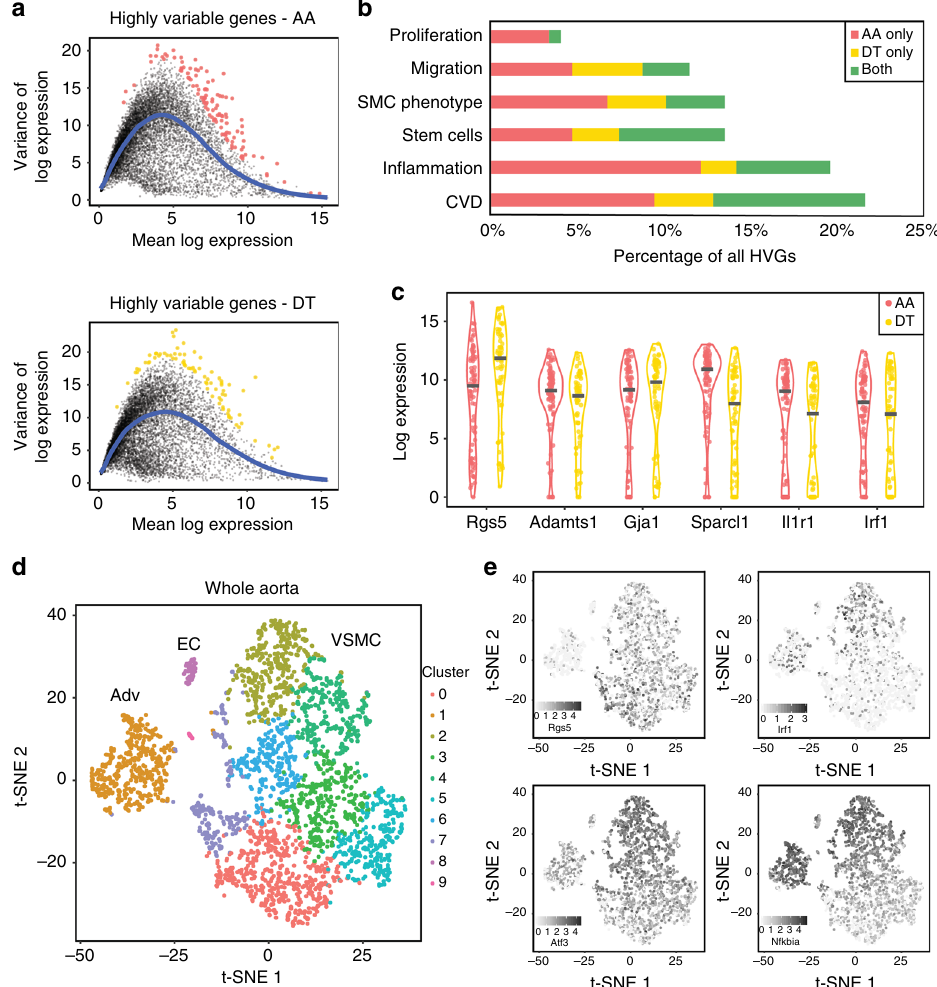
Fig. 4 VSMCs show heterogeneous expression of genes implicated in cardiovascular disease. a Scatter plots showing the mean-variance relationship of log 2 -transformed normalised expression levels for each gene, with colour-highlighting of genes showing highly variable expression in the aortic arch (AA, red, top panel) and descending thoracic aorta (DT, yellow, lower panel). b Bar graph showing the implication of the identi fi ed highly variable genes (HVGs) in AA (red), DT (yellow) or both regions (green) in functions related to VSMC biology based on published literature (see Methods for details). c Dot plot showing log 2 -transformed normalised counts detected in individual VSMCs from AA (red) and DT (yellow) for selected genes that show variable expression across single cells. d , e t-SNE plot visualising a 10X Chromium dataset generated from 2846 unselected cells (gated as live using Zombie NIR staining and singlets using doublet discrimination) from the whole aortas of three tamoxifen-labelled Myh11-CreERt2/Confetti animals (pooled). d Clusters generated using graph-based clustering are colour-coded as indicated and adventitial (Adv), endothelial (EC) and VSMC (VSMC) populations are labelled. e Log-transformed expression levels of selected HVGs identi fi ed in AA and DT populations based on Fluidigm C1 data ( Rgs5 , Irf1 , Atf3 , Nfkbia ), shown using a scale from light to dark